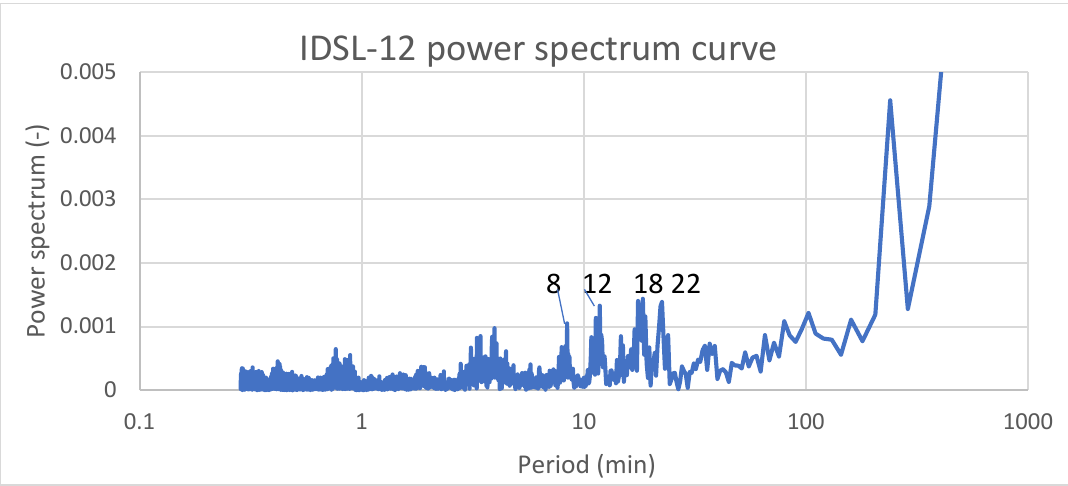
Figure 9. Power spectrum of sea level in Le Castella, Italy.